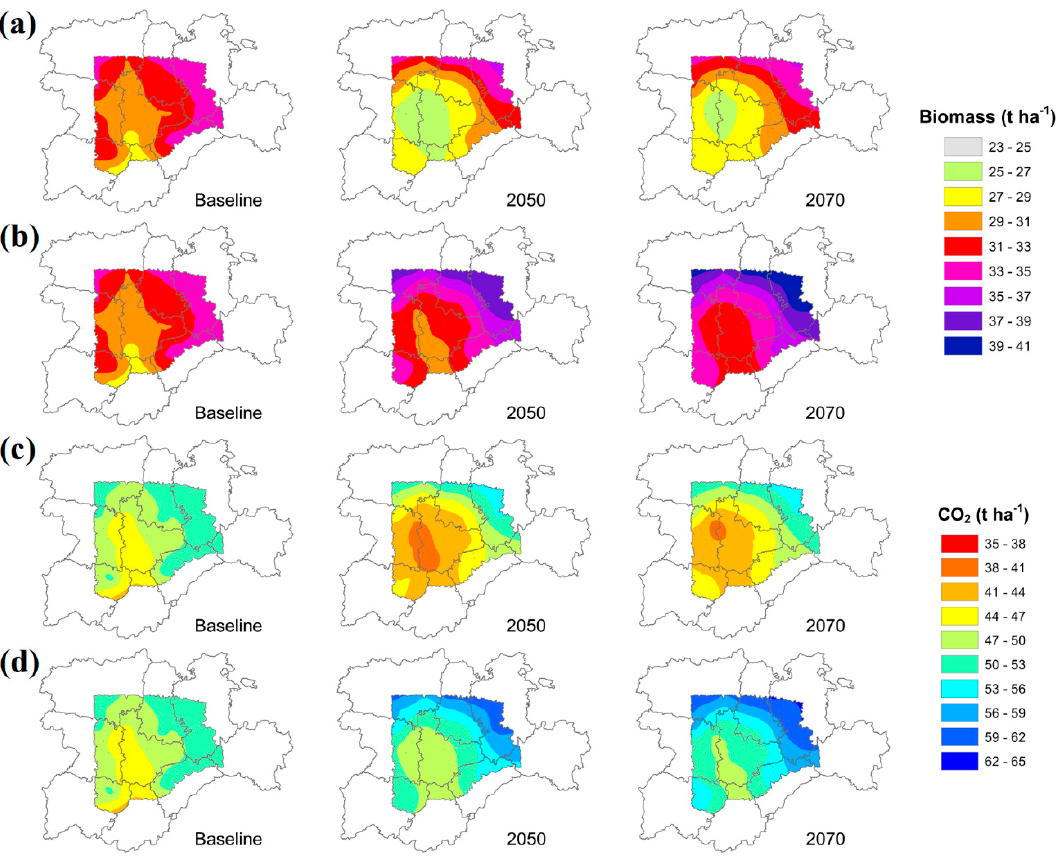
Figure 7. Biomass spatial distribution in the area of study for the baseline, 2050 and 2070 scenarios with ( a ) the usual cultivation period and ( b ) an extended cultivation period. CO 2 sequestration in the area of study for the baseline, 2050 and 2070 scenarios considering ( c ) current cultivation period and ( d ) an extended cultivation period.